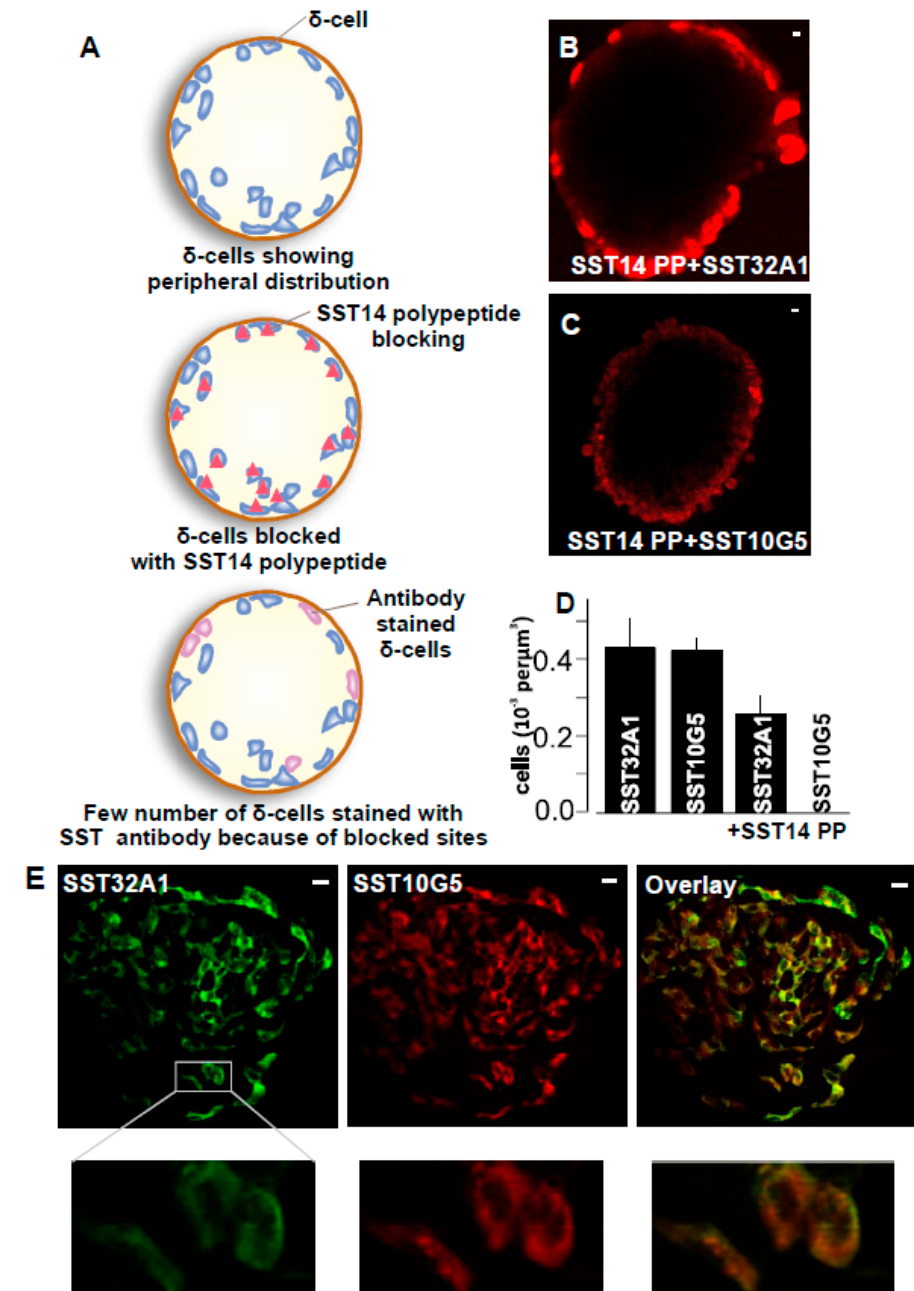
Figure 3. Both SST-14 and SST-28 co-express in mouse islets—( A ) Cartoon representation for blocking of islets with SST14 polypeptide (SST14 PP), ( B ) Images for islets pre-incubated with SST14 PP prior to staining with SST32A1 antibody (Scale bar = 1 µm), ( C ) Images for islets pre-incubated with SST14 PP prior to staining with SST10G5 antibody (Scale bar = 1 µm), (In ( B , C ), the SST10G5 and SST32A1 immunostaining are in red.) ( D ) Number of cells per islet from the experiments as displayed in ( A , B ) in comparison with controls where islets were stained with SST10G5 or SST32A1 without pre-incubation with SST14 polypeptide. Each experiment was repeated on at least 7 islets on two different days using 3–5 mice, ( E ) Islets from mice labelled with SST10G5 that mostly detects SST14 and SST32A1 which mostly detects SST28 and overlays. Zoomed images of single δ -cells from each of the conditions specified on the left side of the image (Scale bar = 10 µ m). (SST32A1 immunostaining is in green, SST10G5 is in